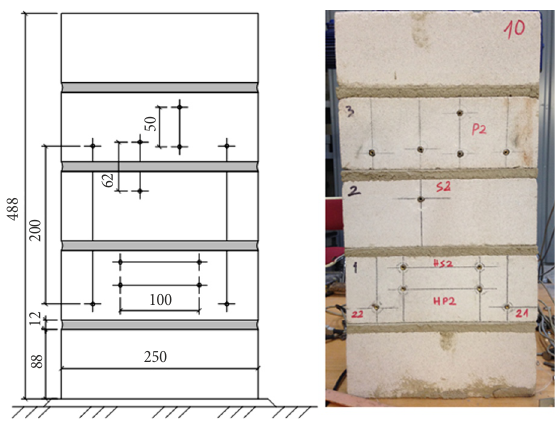
Fig. 1. Masonry fragment composed of 5 250×125×88 mm silicate bricks and of 11–12 mm thickness cement mortar bed